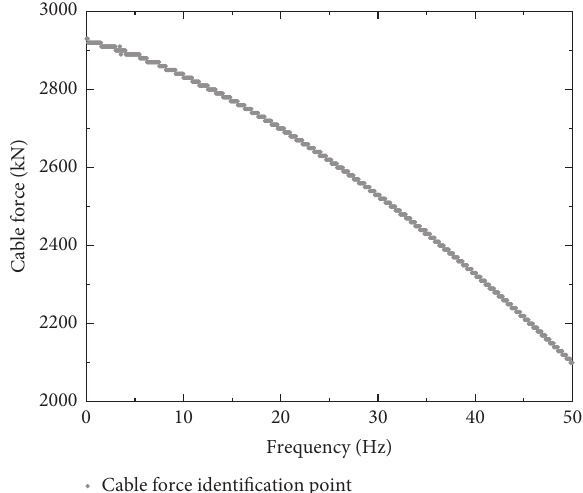
Figure 16: Cable force identification of the resulting diagram.